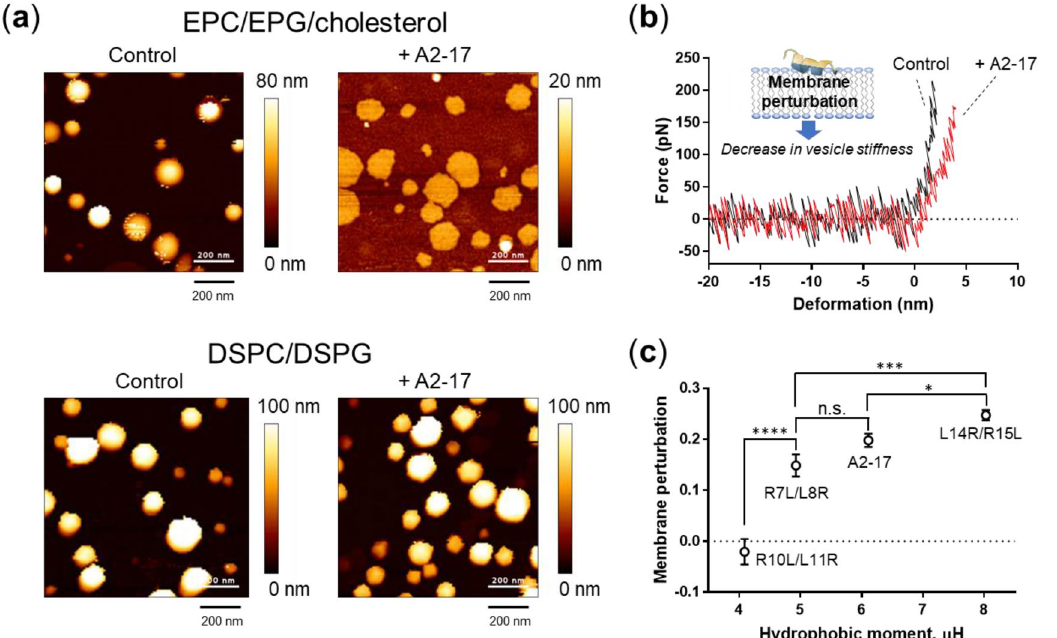
Figure 6. AFM analysis of lipid membrane perturbation caused by A2-17 structural isomers at a lipid/peptide molar ratio of 1. ( a ) AFM images of EPC/EPG/cholesterol-LUVs and DSPC/DSPG-LUVs in the absence (Control) and presence of A2-17 (+ A2-17). Scale bars represent 200 nm. ( b ) Representative force–deformation curves for DSPC/DSPG-LUVs in the absence (Control) and presence of A2-17 (+ A2-17). Membrane perturbation by peptides decreases the slope of the curve, that is, the lipid vesicle stiffness. ( c ) Correlation of membrane perturbations of DSPC/DSPG-LUVs caused by peptides with their hydrophobic moment (μH) values. * p < 0.05; *** p < 0.001; **** p < 0.0001; n.s., not